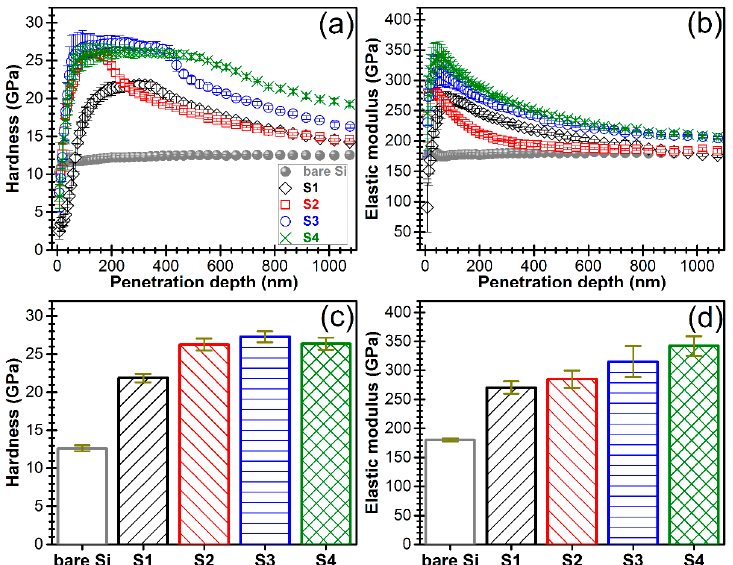
Figure 9. ( a ) Hardness and ( b ) elastic modulus vs. the penetration depth in the case of AlN films with various degrees of c -axis texturing. Graphs depicting the evolution of the ( c ) hardness and ( d ) elastic modulus average values of the AlN films.